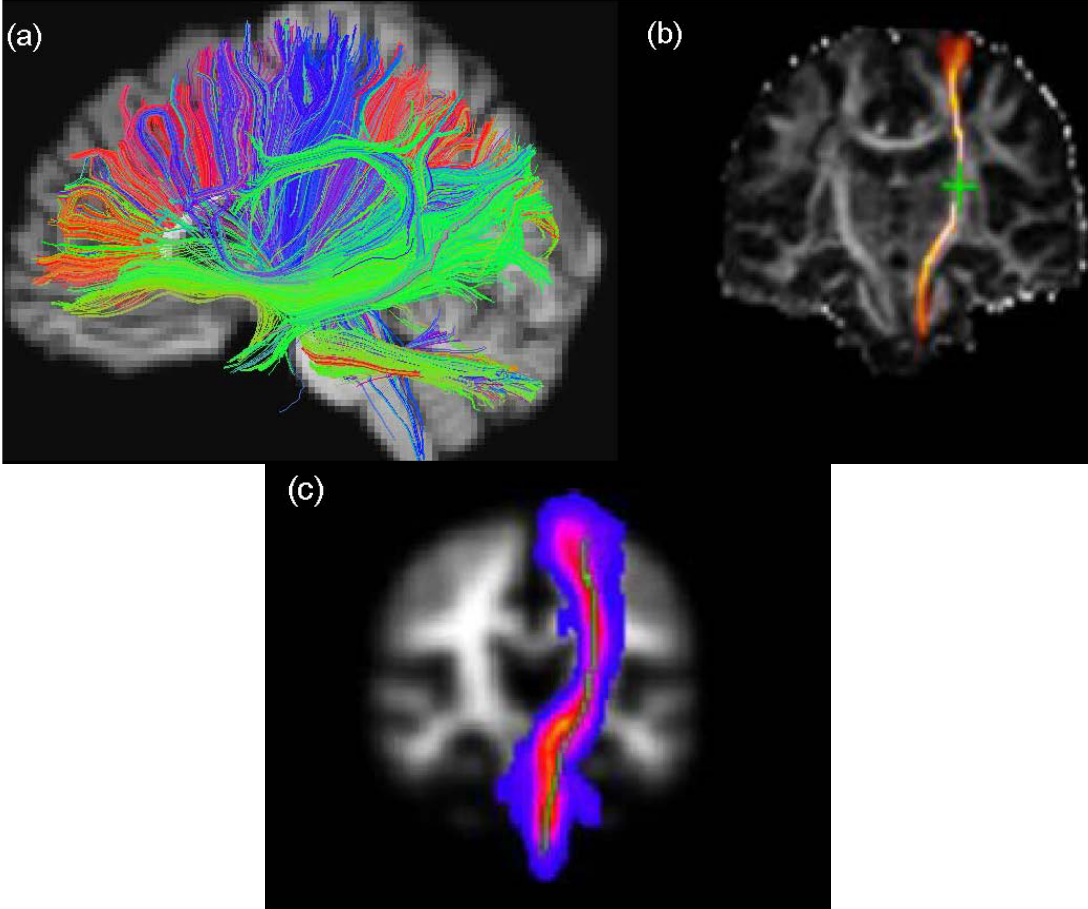
Figure 2. Examples of the visualization of WM tractography data. The figure shows ( a ) whole brain WM overlaid on a high-resolution T -weighted volume scan produced by 1 TrackViz [31], ( b ) left corticospinal tracts of the same participant (CST) generated using FSL’s BedpostX/ProbTrackX algorithm and ( c ) maximum intensity projection of a standard space group map of left CST obtained from 90 participants aged over 65 years using TractoR